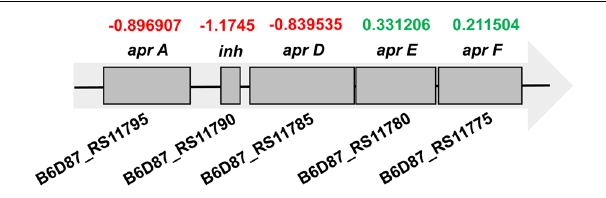
FIGURE 3 | Gene expression pattern of the alkaline protease operon in MAP samples. Numbers above each gene are the log 2 fold change values relative to transcription in controls. Red and green colors represent downregulation and upregulation, respectively.